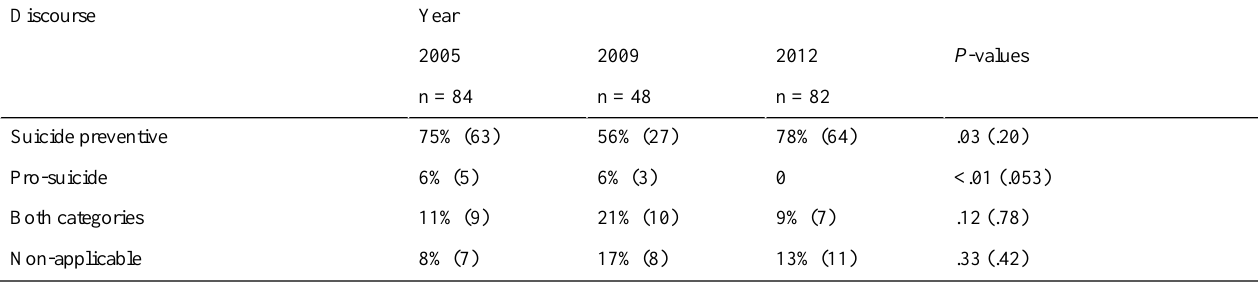
Table 5. The share of search hits on Google on the search term suicide distributed on the variable Discourse. In percent and (frequencies). P -values based on Fisher’s exact test. P -values based on Fisher’s exact test for association (and Cochran-Armitage trend statistic in